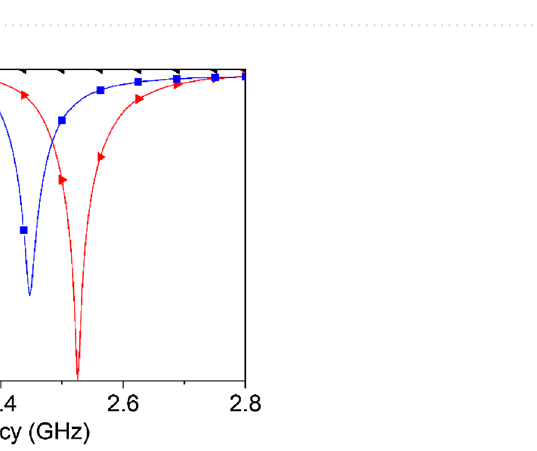
Figure 12. Inhomogeneous human head phantom ( a ) permittivity, ( b ) loss tangent, ( c ) fabricated layered phantom.